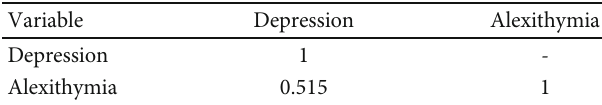
Table 3: Pearson correlation test statistics are related to the relationship between depression and